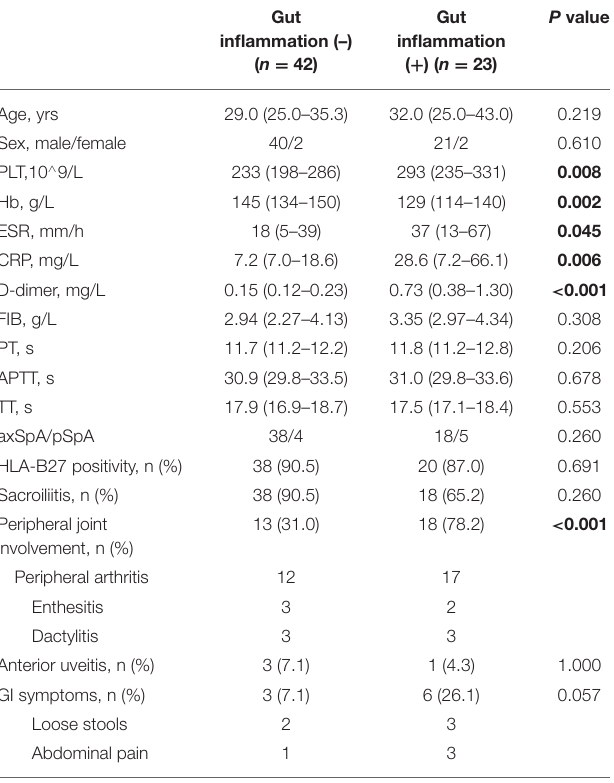
TABLE 2 | Comparisons of demographic, laboratory, and clinical characteristics of patients with SpA between with and without gut inflammation.